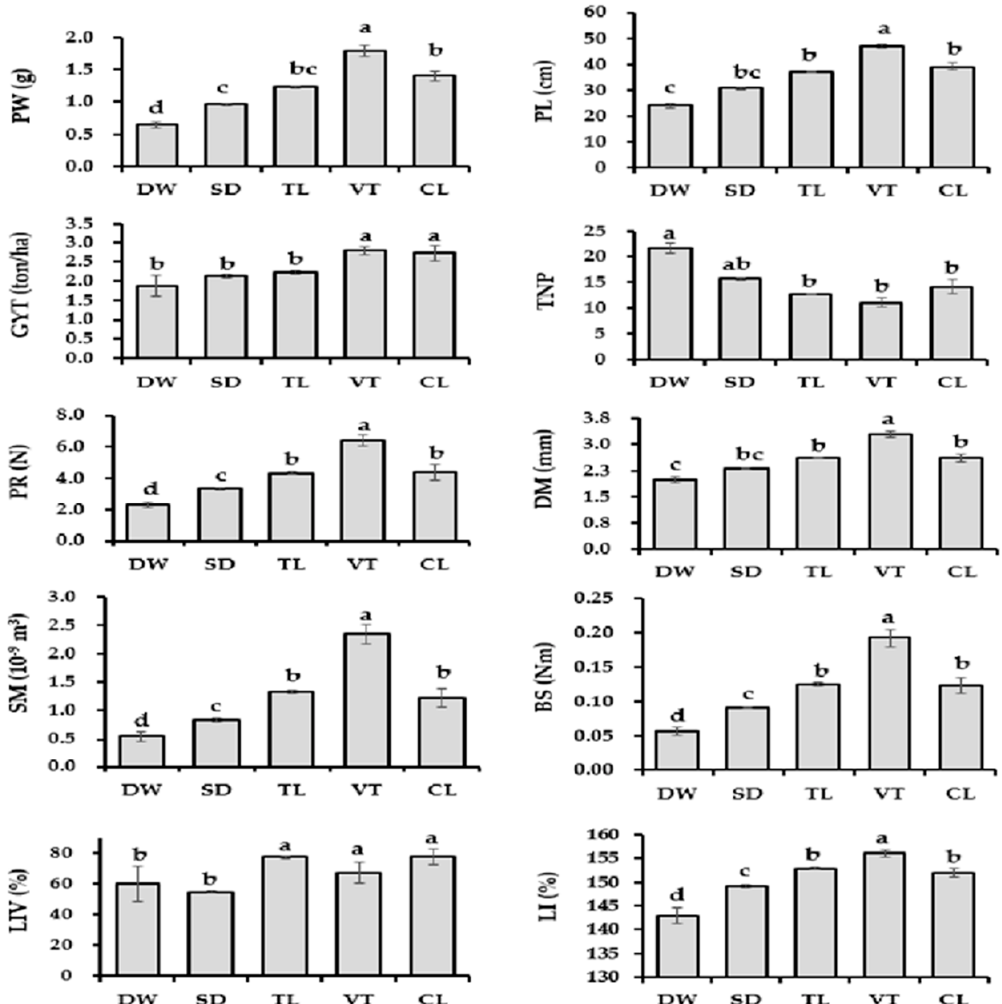
Figure 3. Comparison of genotypes by height group: Dwarf (DW), ≤ 80 cm; Semi-dwarf (SD), 81–100 cm; Tall (TL), 101–120 cm; Very Tall (VT)), ≥ 121 cm and improved cultivars (CL). The CL group comprises the averaged values of the six improved cultivars. Error bars indicate standard error. The same letter above bars indicates no significant di ff erences between the groups ( p < 0.05). The measured or calculated traits are panicle weight (PW), panicle length (PL), grain yield (GY), tiller number per plant (NTP), pushing resistance (PR), second basal internode diameter (DM), section modulus (SM), base failure moment (BS), Lodging index (LI), and Peduncle length